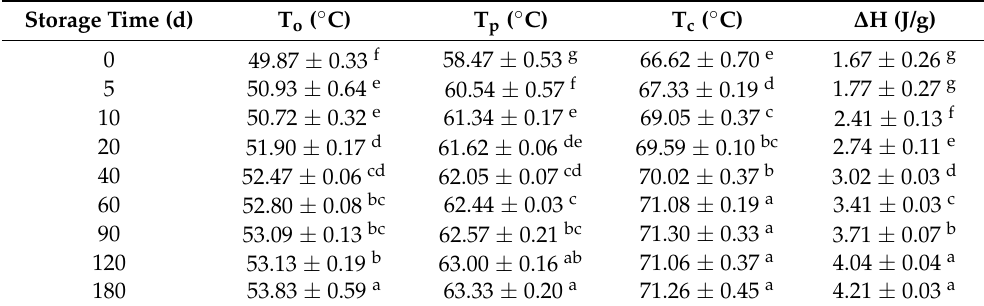
Table 3. Changes in thermal properties of semi-dried rice noodles during storage.